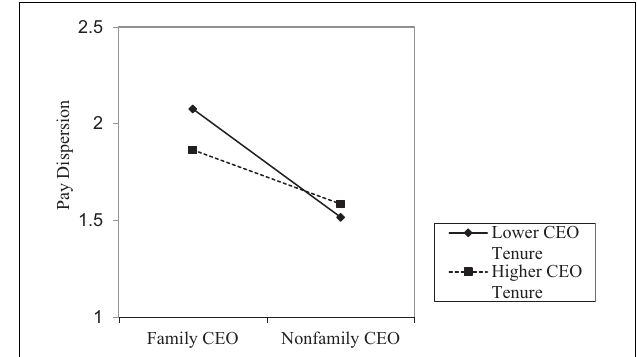
FIGURE 2 | The moderation effect by CEO tenure.